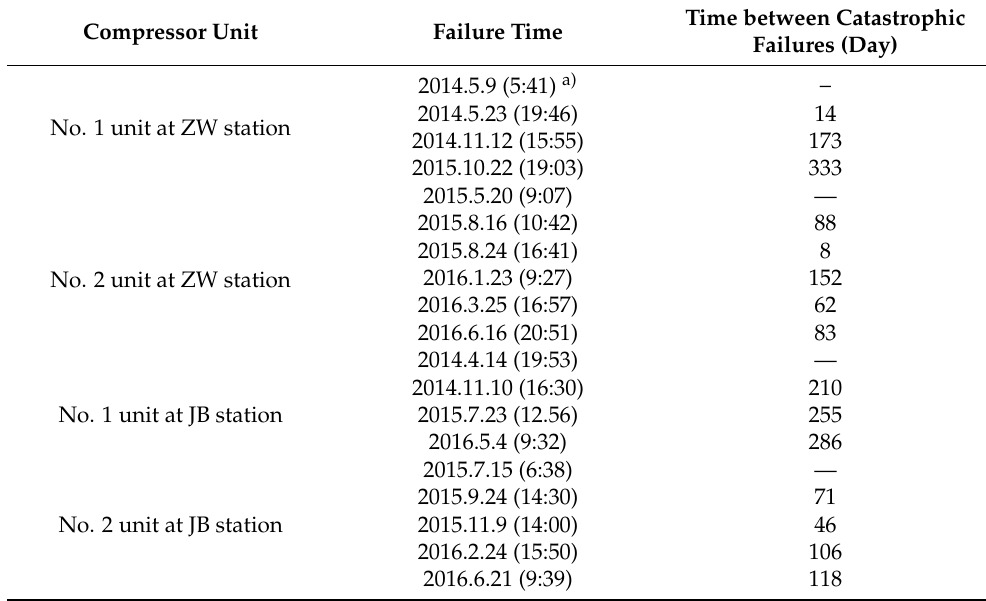
Table 2. The historical failure data derived from the catastrophic failures during the period from 1 January 2014 to 23 August 2016.